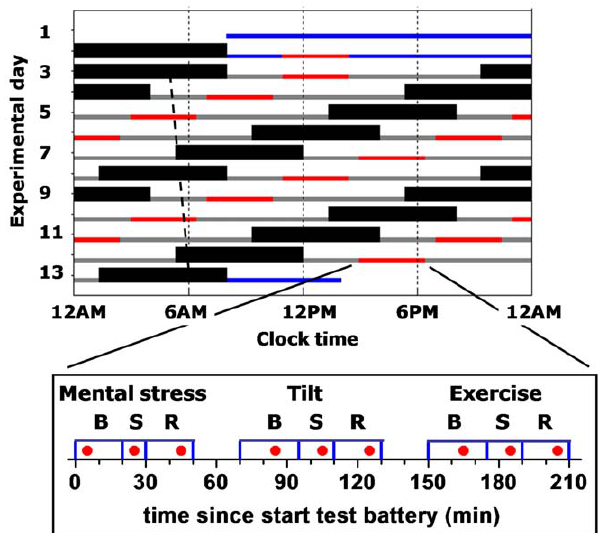
Figure 1. Protocol. Rasterplot, including two baseline days, twelve 20- h cycles, and discharge day of an example subject with a habitual bedtime of midnight. Blue bars, baseline and discharge wake episodes in normal room light ( , 90 lux); solid back bars, scheduled sleep (0 lux); gray bars, wake episodes in dim light ( , 1.8 lux); red bars, timing of the test batteries; dotted line illustrates the circadian core body temper- ature minimum throughout the protocol, with an average circadian period of 24.09h in these subjects. Each test battery consisted of a mental, tilt, and exercise stress (S) test, each preceded and followed by a baseline (B) and recovery (R) episode. The timing of the blood draws is indicated as red filled circles.